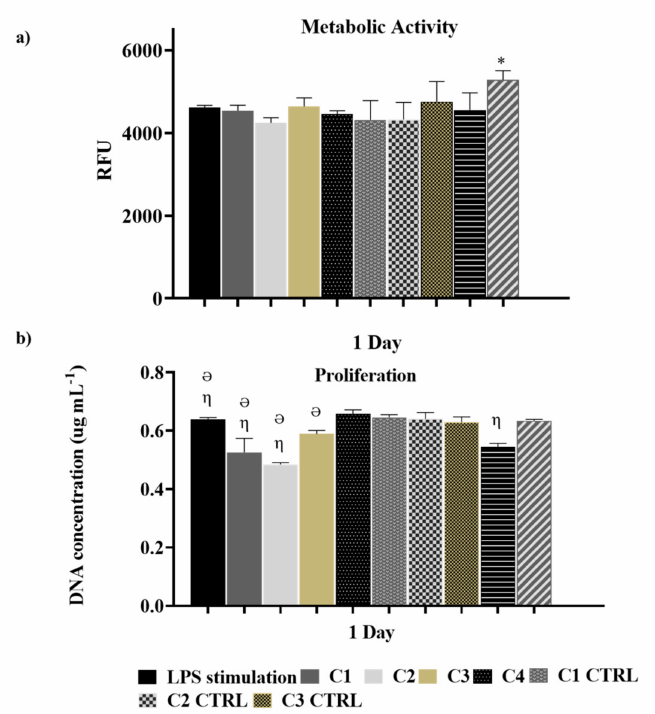
Figure 4. Evaluation of anti-TNF α Ab-CS/ PAMAM dendrimer NPs loaded-Ty-GG and Ty-GG/SF hydrogels effects on cells metabolic activity and proliferation. ( a ) THP-1 cells’ metabolic activity upon culture with anti-TNF α Ab-CS/ PAMAM dendrimer NPs loaded-Ty-GG (C1 and C2) and Ty-GG/SF (C3 and C4) hydrogels and controls for 1 day of culture. (* indicates significant differences when comparing Dendrimer NPs with LPS stimulation at time point 1 day); and ( b ) THP-1 cells’ proliferation by DNA quantification of THP-1 cells upon culture with anti-TNF α Ab-CS/ PAMAM dendrimer NPs loaded-Ty-GG (C1 and C2) and Ty-GG/SF (C3 and C4) hydrogels and controls for 1 day of culture. ( η indicates significant differences when comparing with LPS stimulation. @ indicates significant differences when comparing with respective CTRL). Data shown as Mean ± SD.